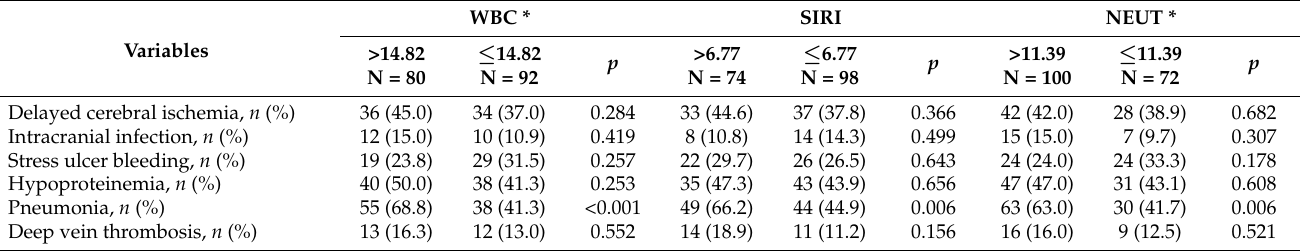
Table 7. Associations between inflammatory biomarkers and in-hospital